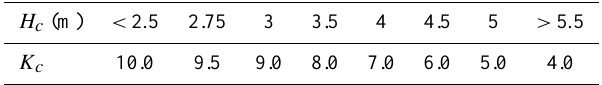
Table 4. The calculation results of debris-flow parameters in